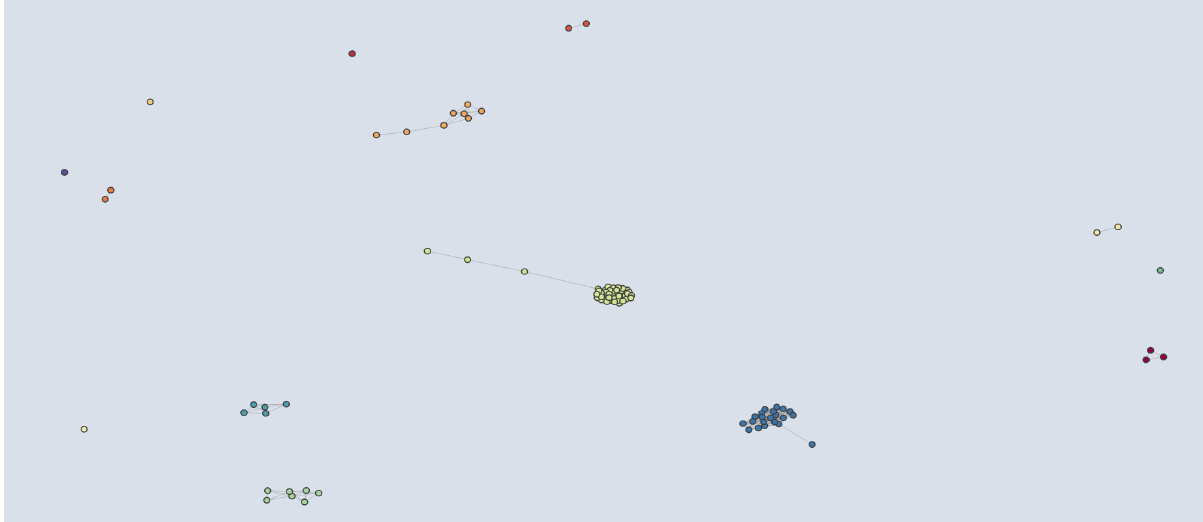
Figure 8. Clustering of 90 coins. Each node represents a coin and coins of the same cluster are linked together and have the same